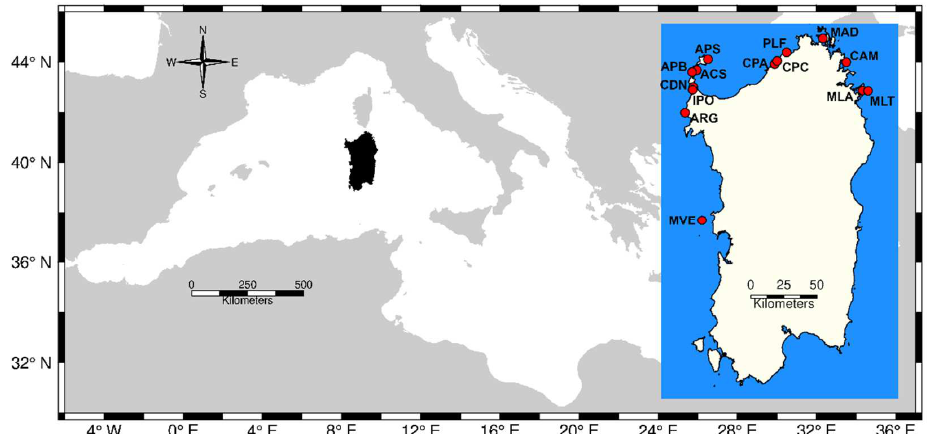
Figure 1. Location of sampling sites (red circles in the inset) in Sardinia Island (highlighted in black). APS = Punta Sabina, Asinara island; ACS = Cala Sant’Andrea, Asinara island; APB = Pedra Bianca, Asinara island; CDN = Coscia di Donna; IPO = Isola dei Porri; ARG = Argentiera; MVE = Mal di Ventre island; CPA = Costa Paradiso site A; CPC = Costa Paradiso site C; PLF = Punta Li Francesi; MAD = La Maddalena island; CAM = Le Camere island; MLA = Molara island; MLT = Molarotto island.